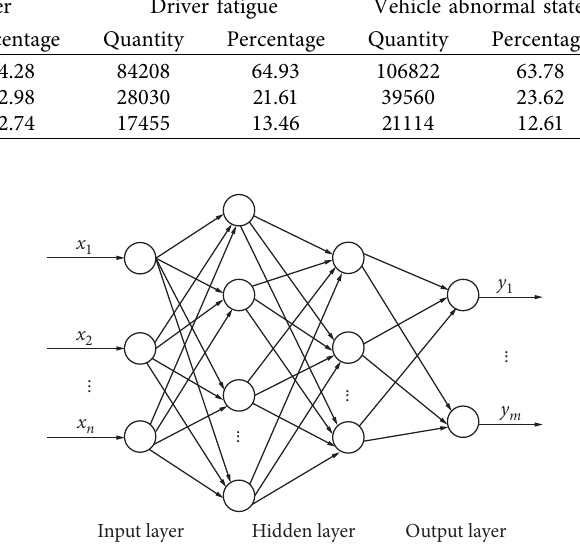
Figure 15: Topological structure diagram of BP neural